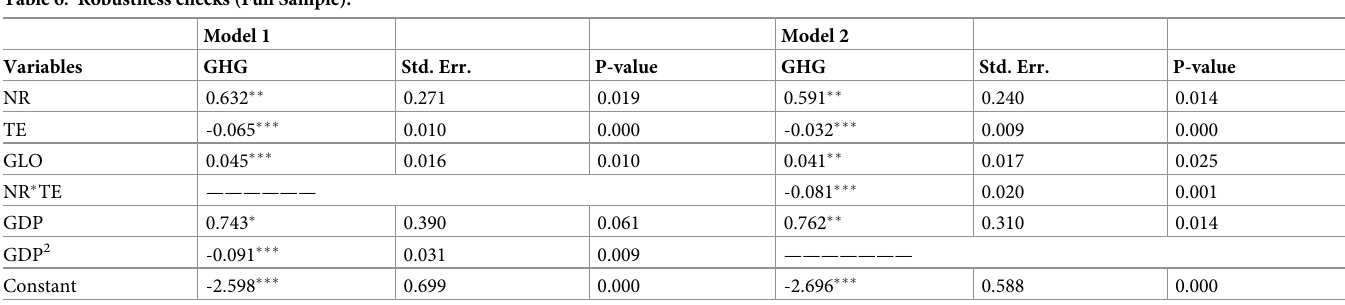
Table 6. Robustness checks (Full